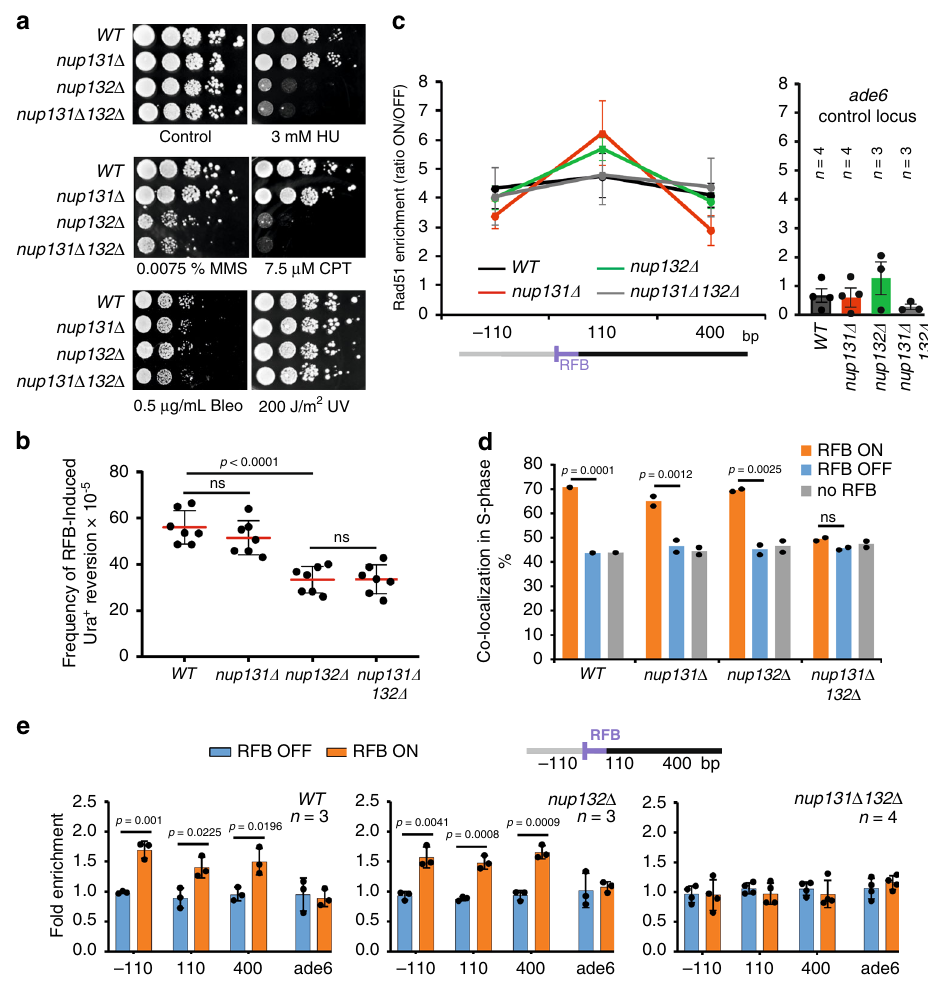
Fig. 4 Nup132 promotes HR-mediated DNA synthesis, downstream of Rad51 binding, in a post-anchoring manner. a Sensitivity of indicated strains to indicated genotoxic drugs. Ten-fold serial dilution of exponential cultures were dropped on appropriate plates. Bleo bleomycin; CPT camptothecin; HU hydroxyurea; MMS methyl methane sulfonate and UV: Ultra Violet-C. See supplementary Fig. 4 for the characterization of macromolecules transport and supplementary Fig. 5 for replication defect upon HU-fork stalling. b Frequency of RFB-induced Ura + reversion in indicated strains and conditions. Each dot represents one sample from seven independent biological replicate for each strain. Bars indicate mean values± SD. p value was calculated by two-sided t -test. c Binding of Rad51 to the RFB in indicated strains as described on Fig. 3e. Values are mean from n independent biological replicates ± SEM. d Co- localization event in S-phase cells in indicated conditions and strains. In all, 250 cells were analyzed for each condition and strain. p value was calculated by Fisher ’ s exact test for OFF and ON groups for each mutant and condition. Dots represent values obtained from two independent biological experiments. For each set of data, WT strain was analyzed alongside mutants. e Binding of Npp106-GFP to the RFB in indicated strains. Upstream and downstream distances from the RFB are presented in bp. Primers targeting ade6 gene were used as unrelated control locus. Values are mean of n independent biological repeats ± SD. p value was calculated using two-sided t